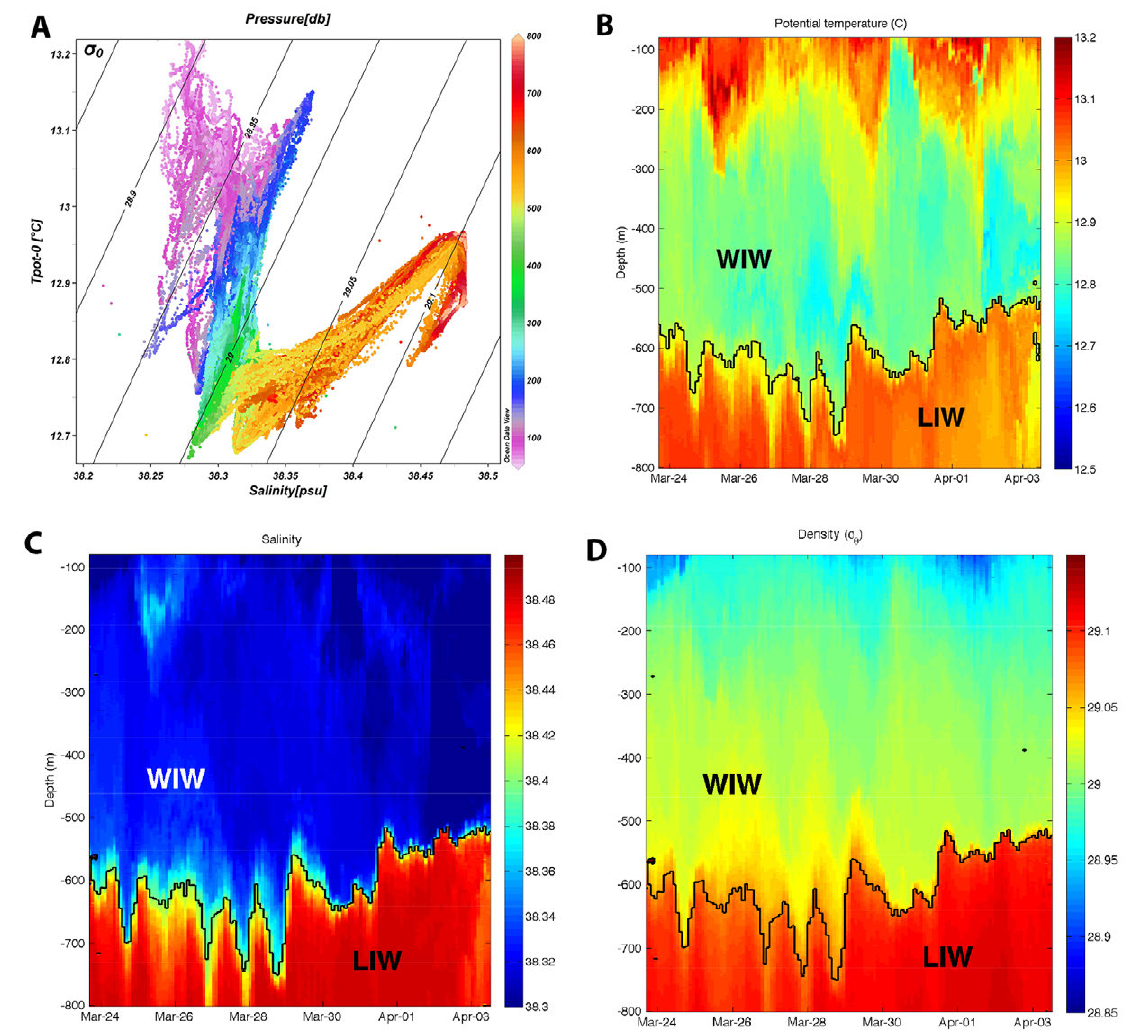
Fig. 3. – A, potential temperature-salinity diagram of the whole set of profiles acquired by the Aqualog. Black lines indicate density levels in sigma-t units. The colour scale indicates the pressure level in db. Panels B, C and D show the time evolution of the potential temperature, salinity and density, respectively. The black line in each B, C and D plot shows the separation between WIW and